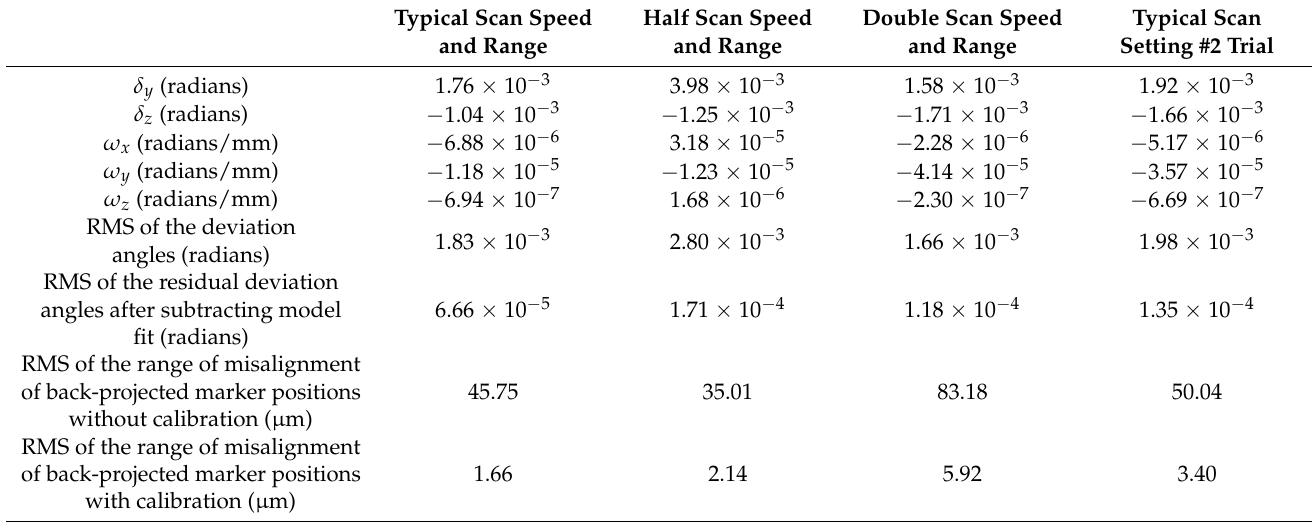
Table 1. List of the calibrated geometric parameters for different scan settings. The RMS of the residual deviation angles of the scan trajectories of the markers after subtracting the model fit was <7.5% of the starting values. The residual range of misalignment of the marker positions in the back-projected images was based on reconstruction using the estimated geometric parameters. It was <7.2% of the uncalibrated levels. Typical Scan Speed Half Scan Speed Double Scan Speed Typical Scan and Range and Range and Range Setting #2